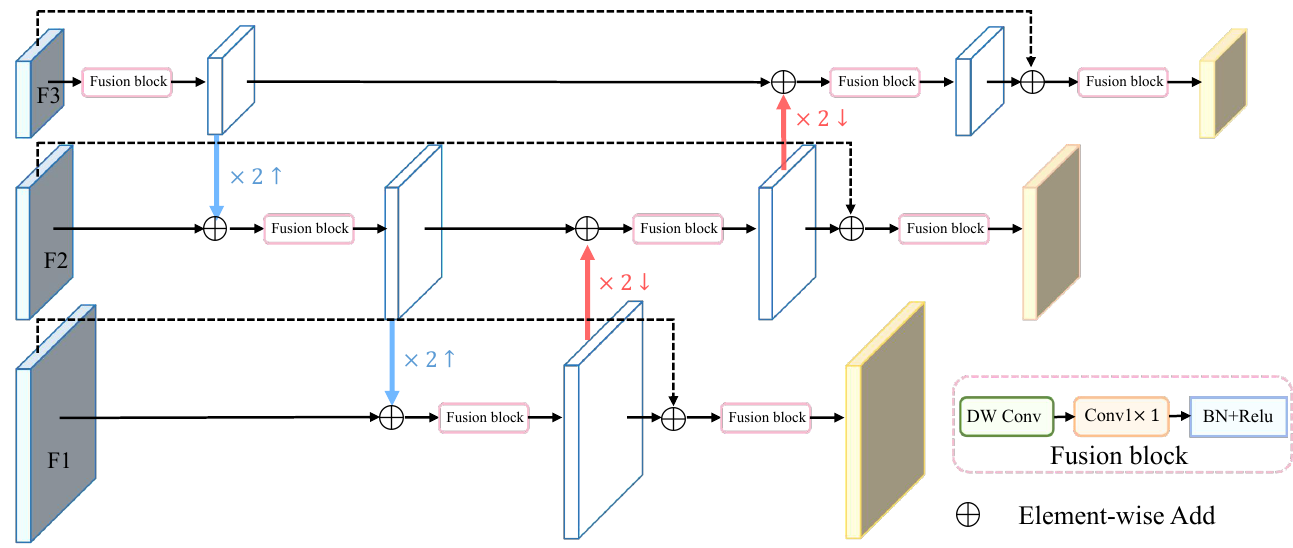
Figure 4. Multi-scale feature fusion